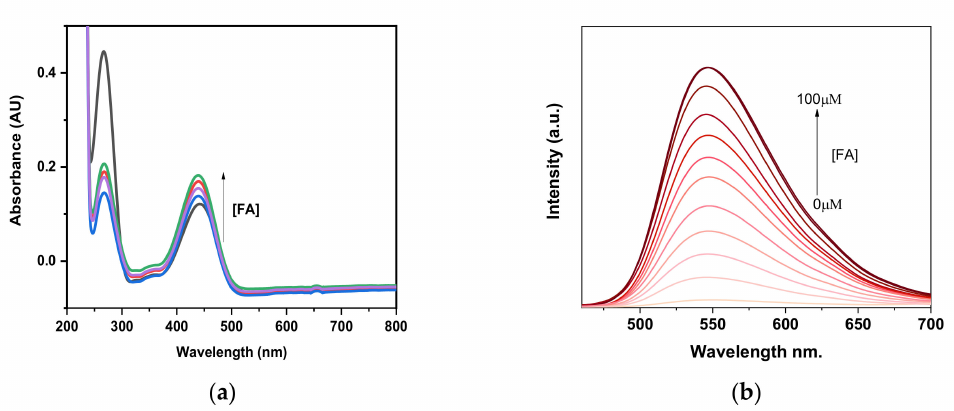
Figure 1. The evolution of the absorption ( a ) and fluorescence emission ( b ) spectra of probe EW2 (10 and 5 µ M, respectively) with increasing concentrations of FA (0–100 µ M) in 10 mM PBS buffer (pH 7.4, 1%